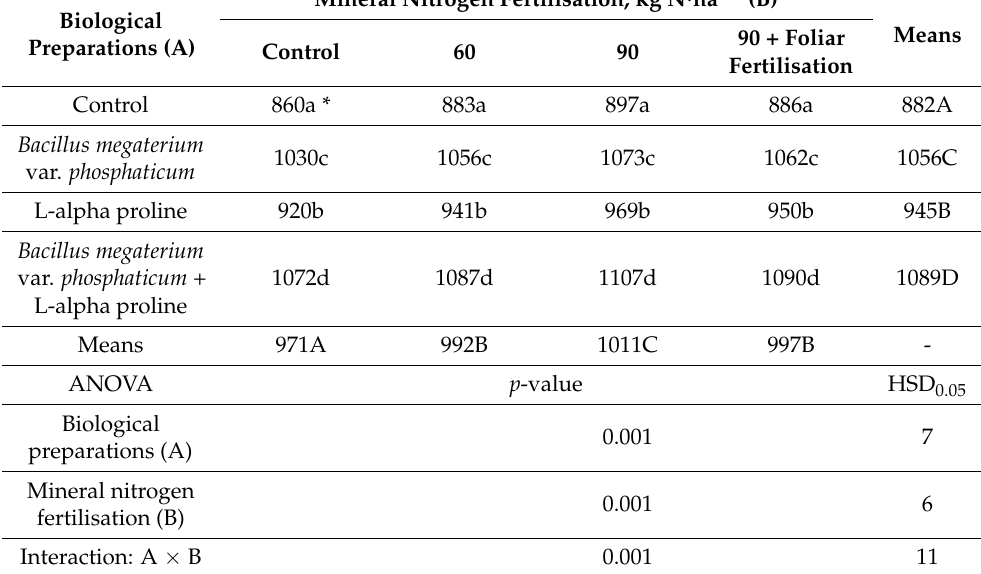
Table 3. Fe content in topsoil 30 days after biological product application (means across 2017–2019), mg · kg − 1